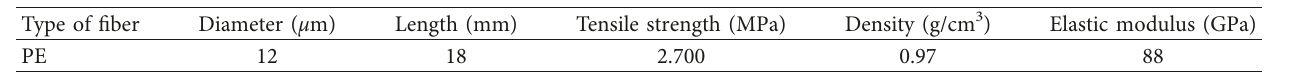
Table 3: Properties of fibers.